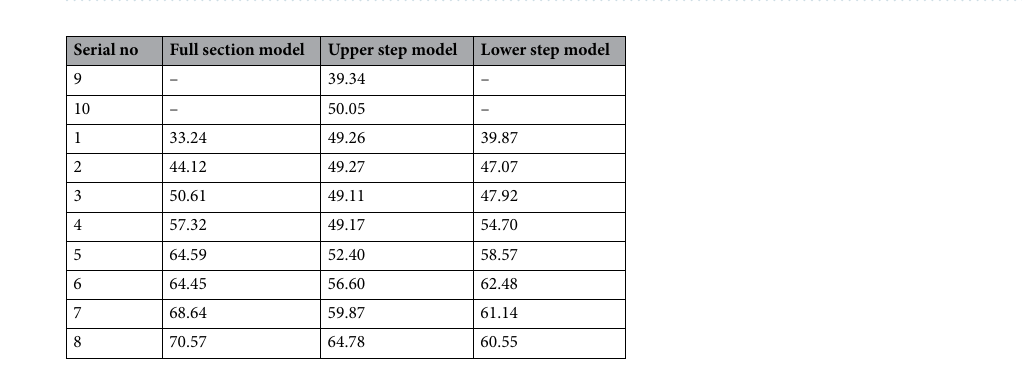
Figure 11. Spectrogram of particle vibration velocity waveform: ( a ) Full section model. ( b ) Upper step model. ( c ) Lower step model.